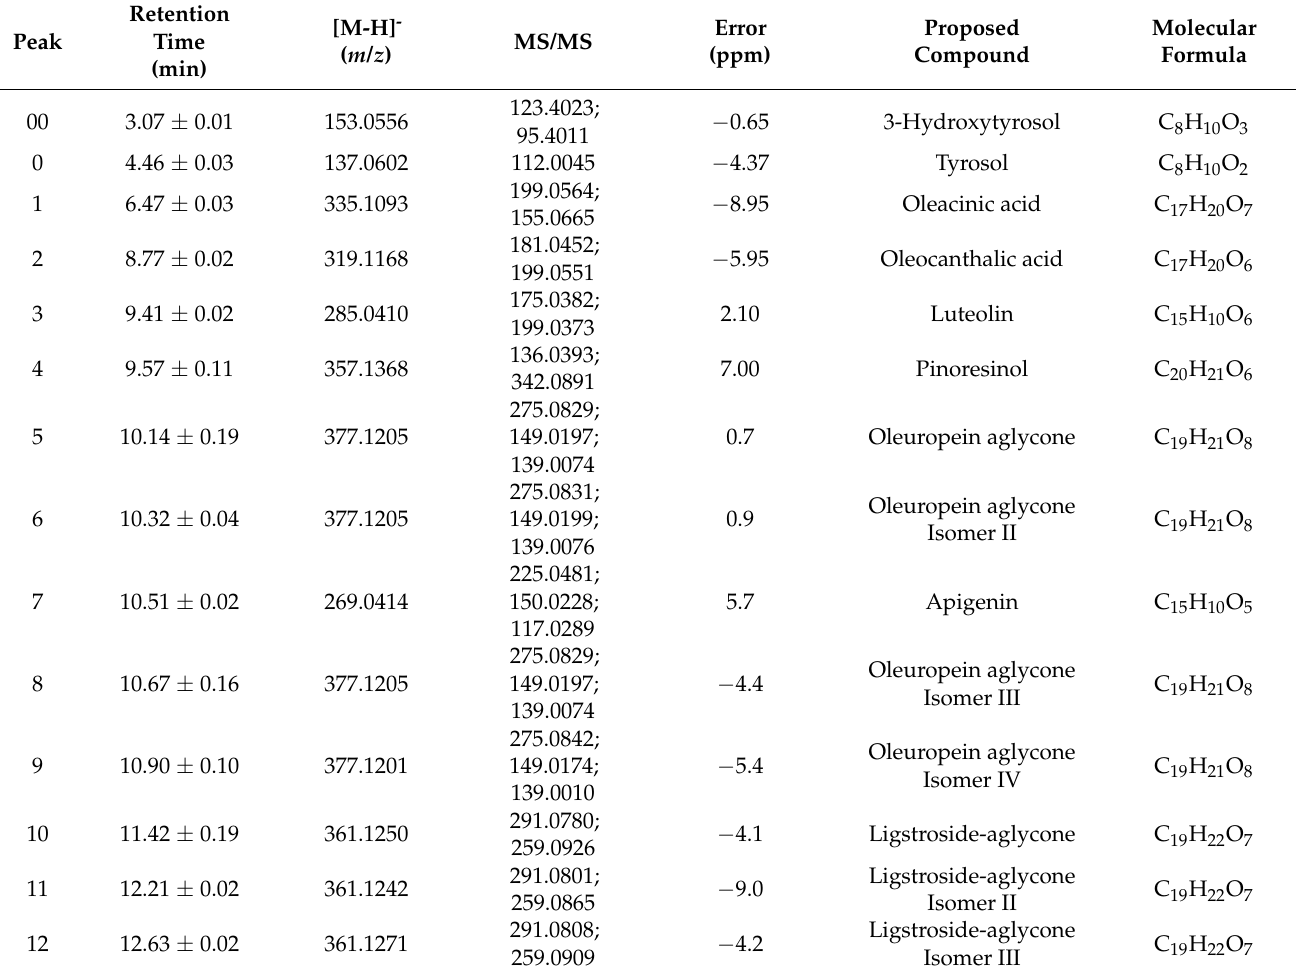
Table 4. UHPLC-HRMS qualitative analysis of the major components in EVOO extracts OE_05 , OE_10 , and OE_15